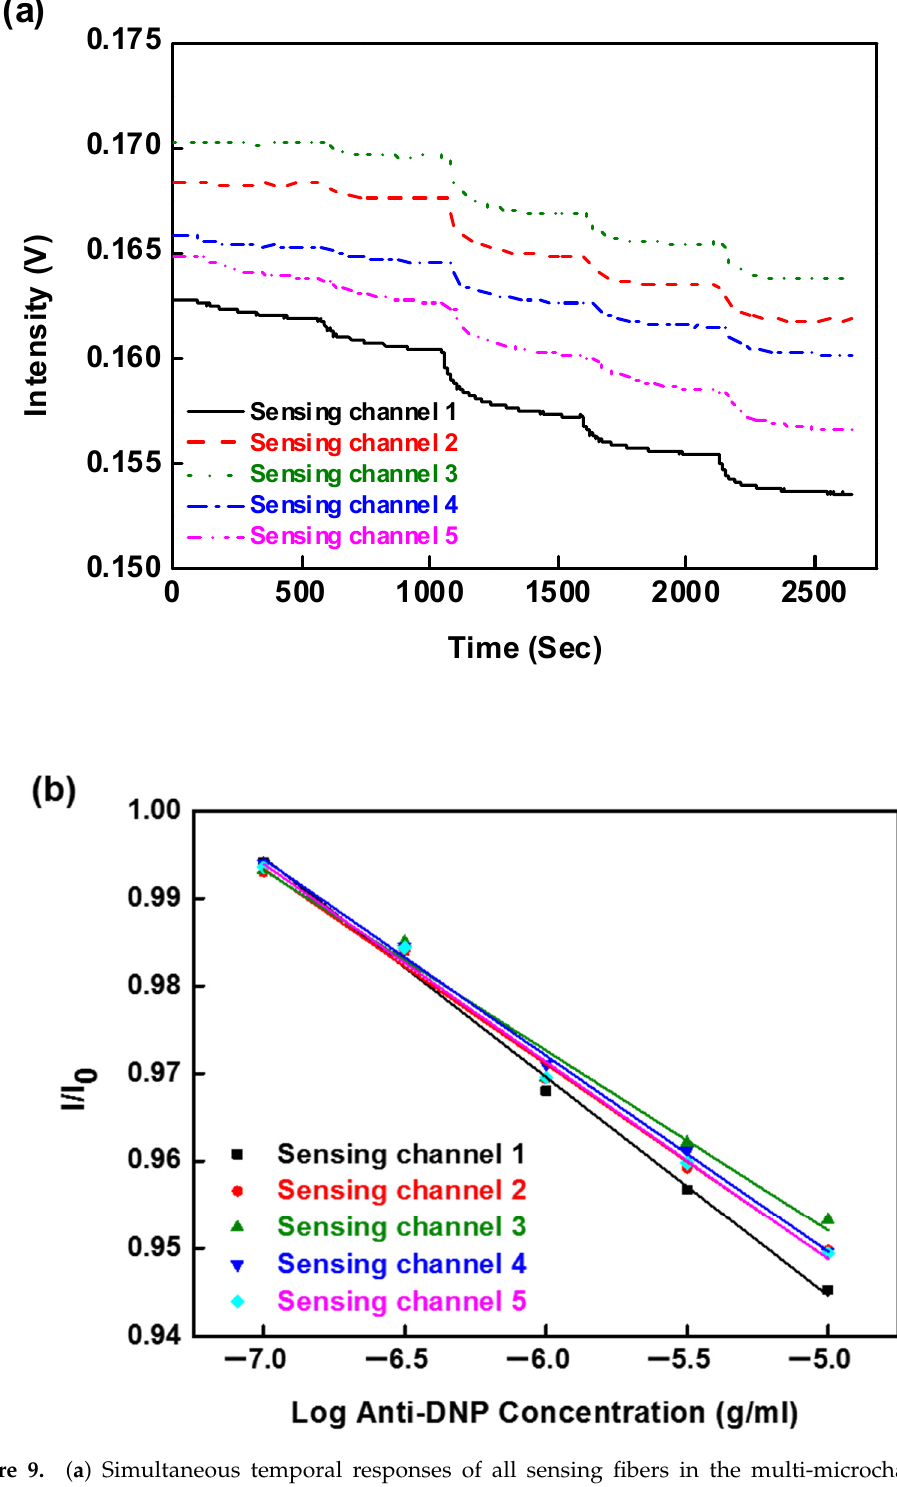
Figure 9. ( a ) Simultaneous temporal responses of all sensing fibers in the multi-microchannel FOPPR sensor with serial injection of anti-DNP solutions; ( b ) calibration graph obtained with the DNP-functionalized probes for anti-DNP by the multi-microchannel sensing system.